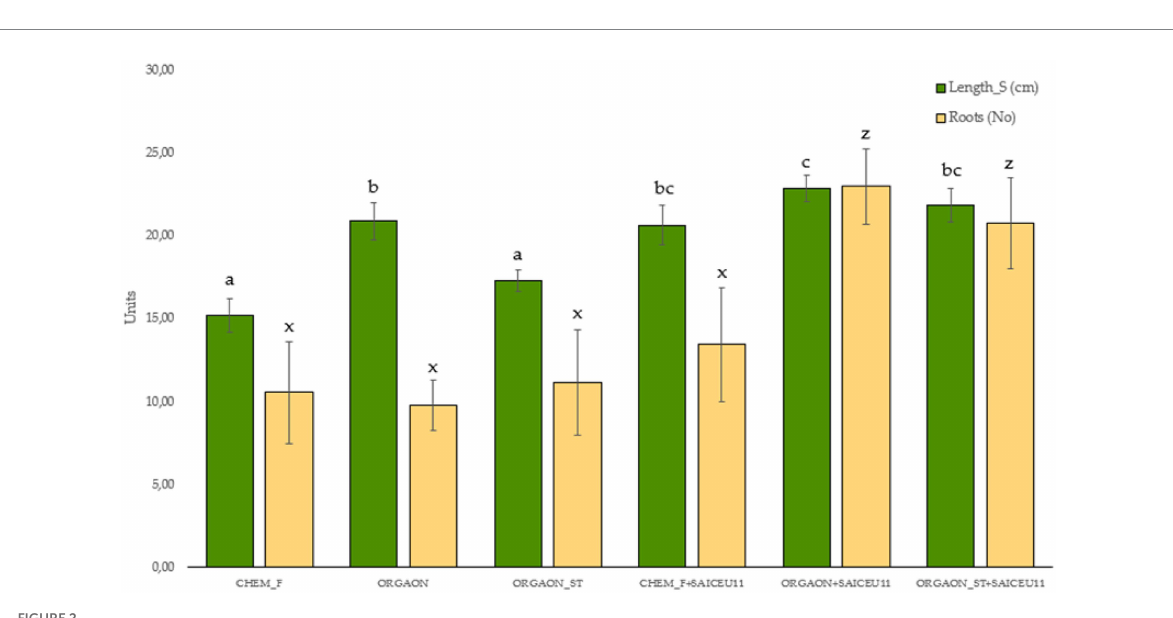
FIGURE 2 Biometrics of lupine plants subjected to different irrigation treatments with biofertilizer with SAICEU11 T . Different letters denote statistically significant differences according to Duncan test ( p < 0.05) for shoot length (a, b, bc, and c) and the number of secondary roots ( x and z ).